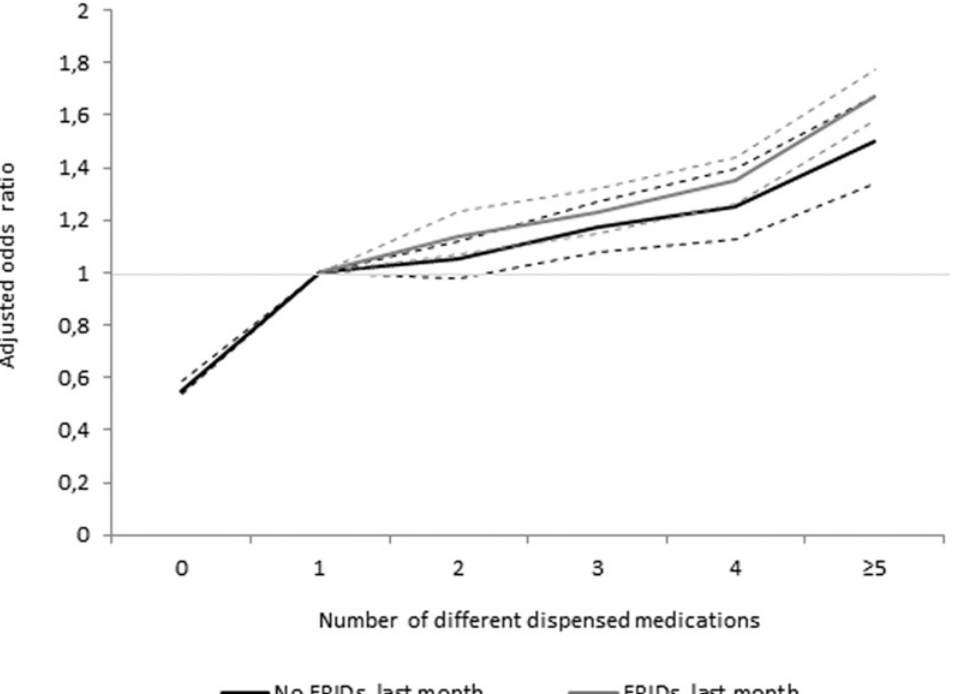
Fig 2. Odds ratio for injurious falls by number of medications stratified by dispensed FRIDs last 30 days, adjusted including 95% confidence intervals (dotted lines).